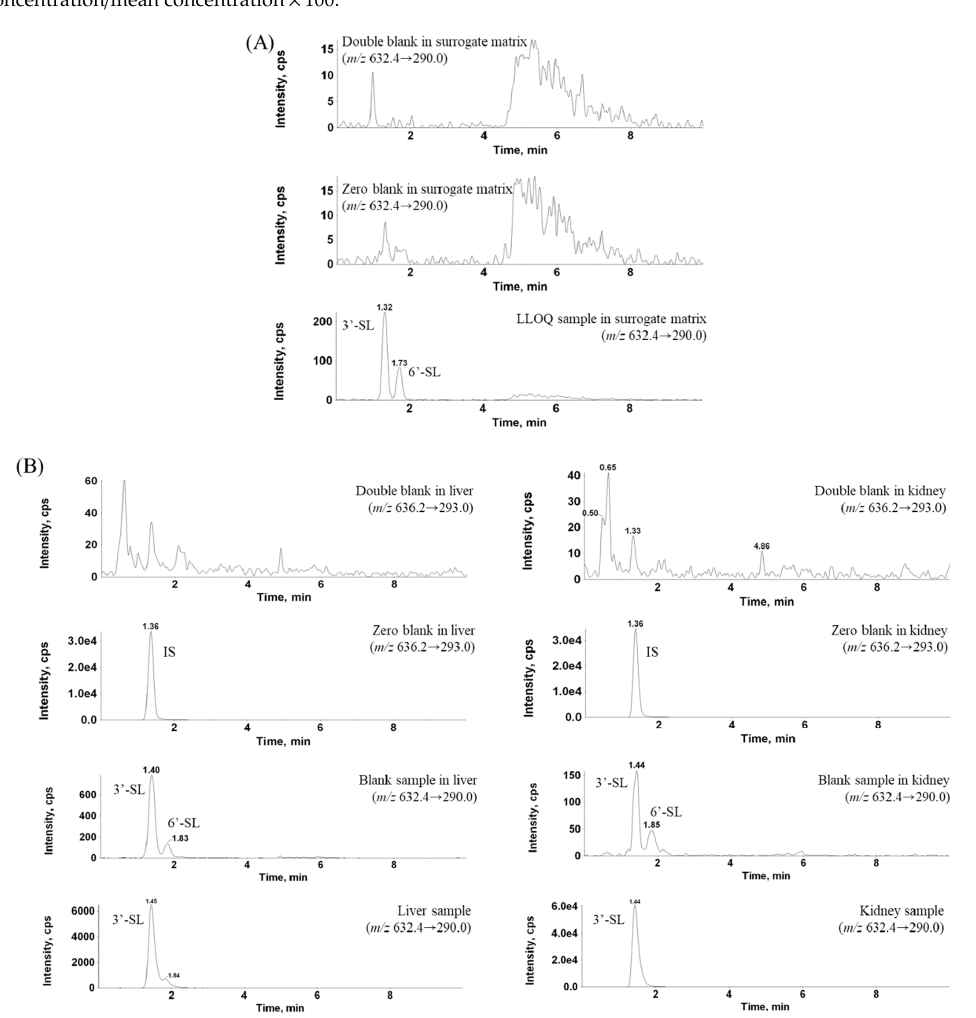
Figure 2. Multiple-reaction monitoring (MRM) chromatograms of ( A ) surrogate matrix and ( B ) liver and kidney: double blank, zero blank, and lower limit of quantification (LLOQ) in surrogate matrix, and double blank, zero blank, blank, and pharmacokinetic application samples for the liver and kidney.